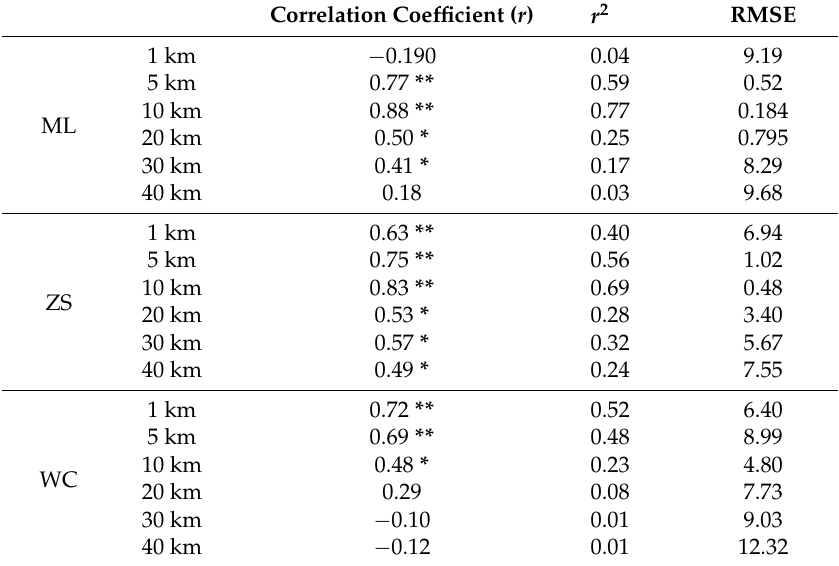
Table 2. Statistical data for the correlation coefficients between the erosion modulus and algae within different buffer regions ( * p < 0.05; ** p <